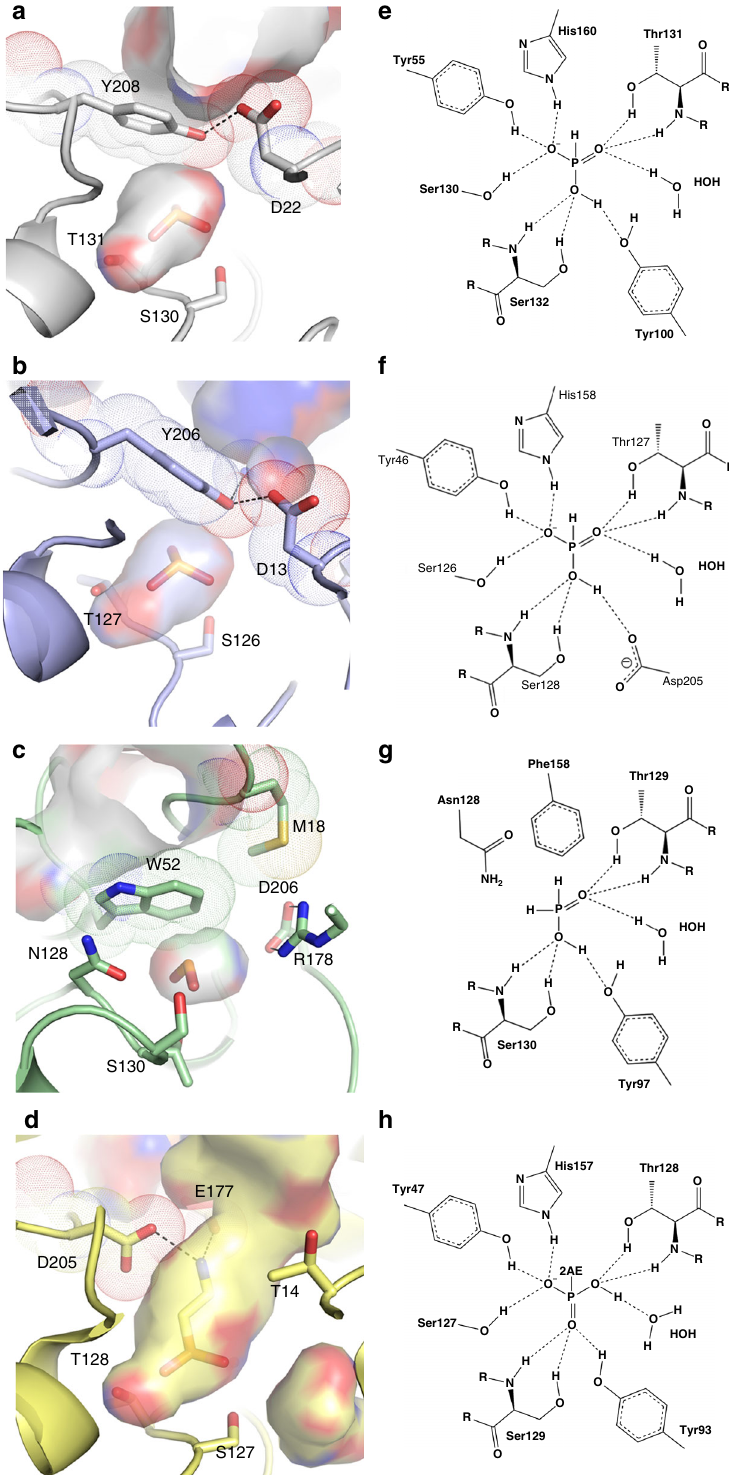
Fig. 2 A detailed comparison of the spatial arrangement of the binding pocket and network of interactions around the ligand. The interior surface (partially transparent, atom colours) of the binding pocket and surrounding residues (sticks) in a Te_PtxB; b Pm_PhnD; c HtxB and d E. coli PhnD (PDB:3P7I). In each case, the capping residues are highlighted with a dotted surface that represents the van der Waals radii of the atoms. The external surface is also shown in each case, demonstrating how the binding pocket in reduced phosphorus binding PBPs ( a – c ) is buried from the external solvent and in each case is much smaller than that of the phosphonate binding PhnD from E. coli ( d ). The protein backbone is drawn as a cartoon, with sidechains drawn in sticks and hydrogen bonds between the capping residues indicated by black dashes. Each fi gure ( a – d ) is accompanied by a schematic ( e-h ) that displays the hydrogen-bonding network between the protein and the oxygen atoms of the ligand. The 2-aminoethyl group of 2AEPn is abbreviated to 2AE in